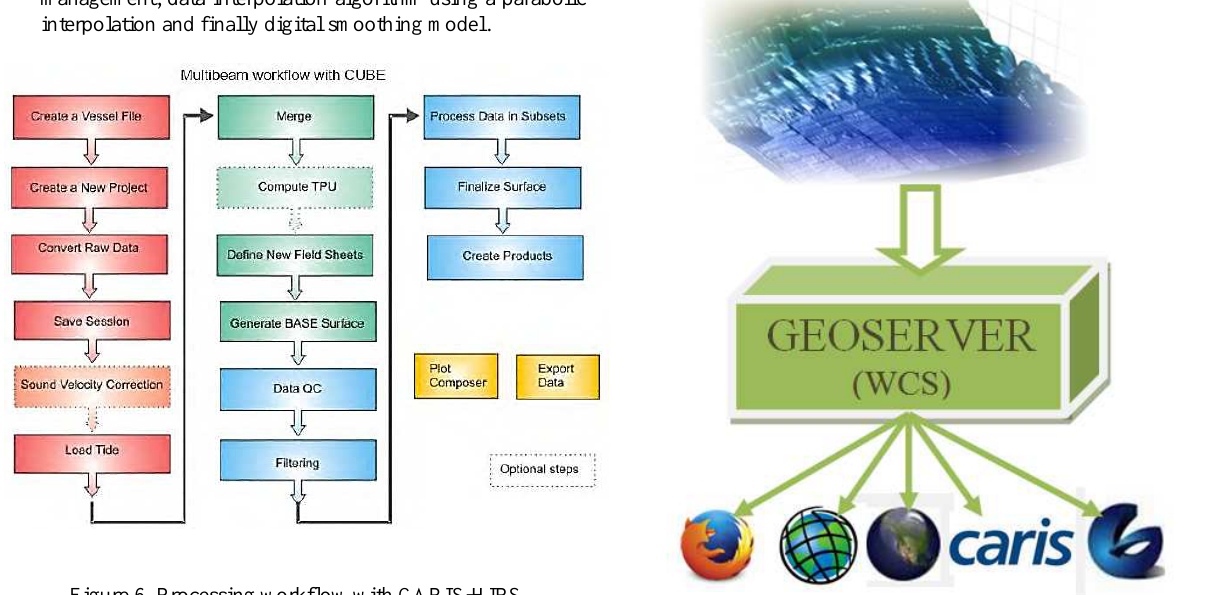
Figure 7. Web Coverage